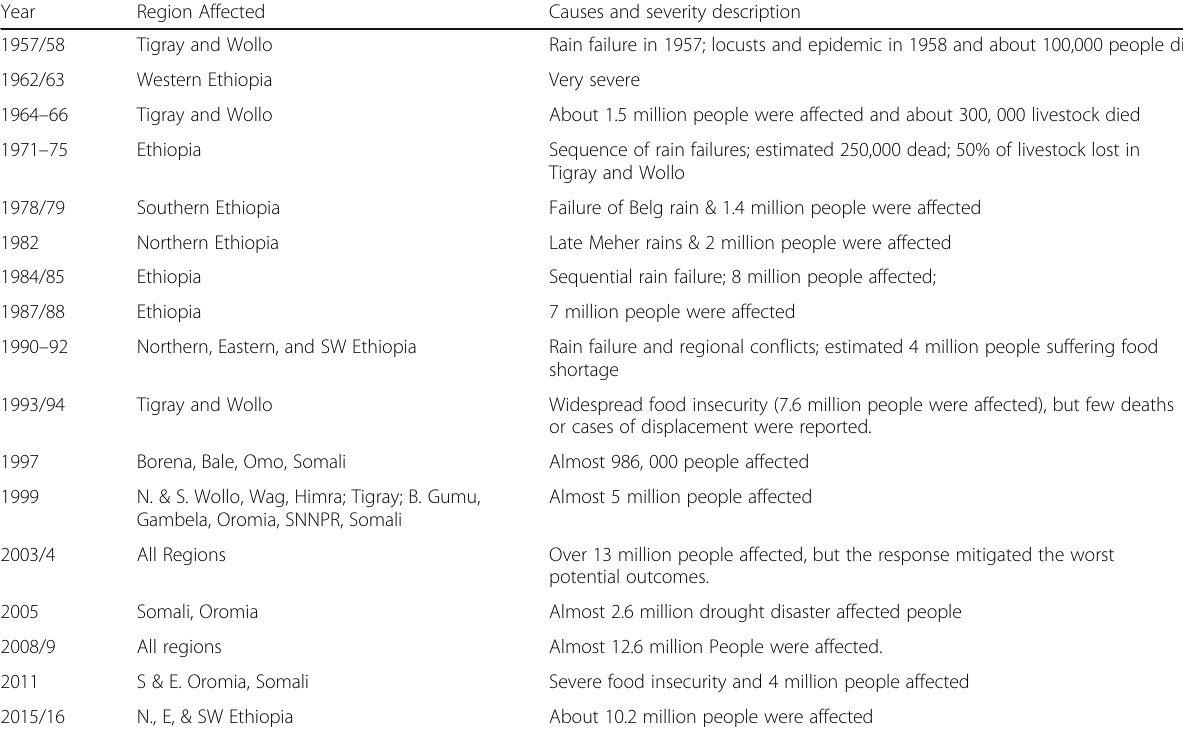
Table 1 Reported drought years, regions affected, causes and severities since the 1960s in